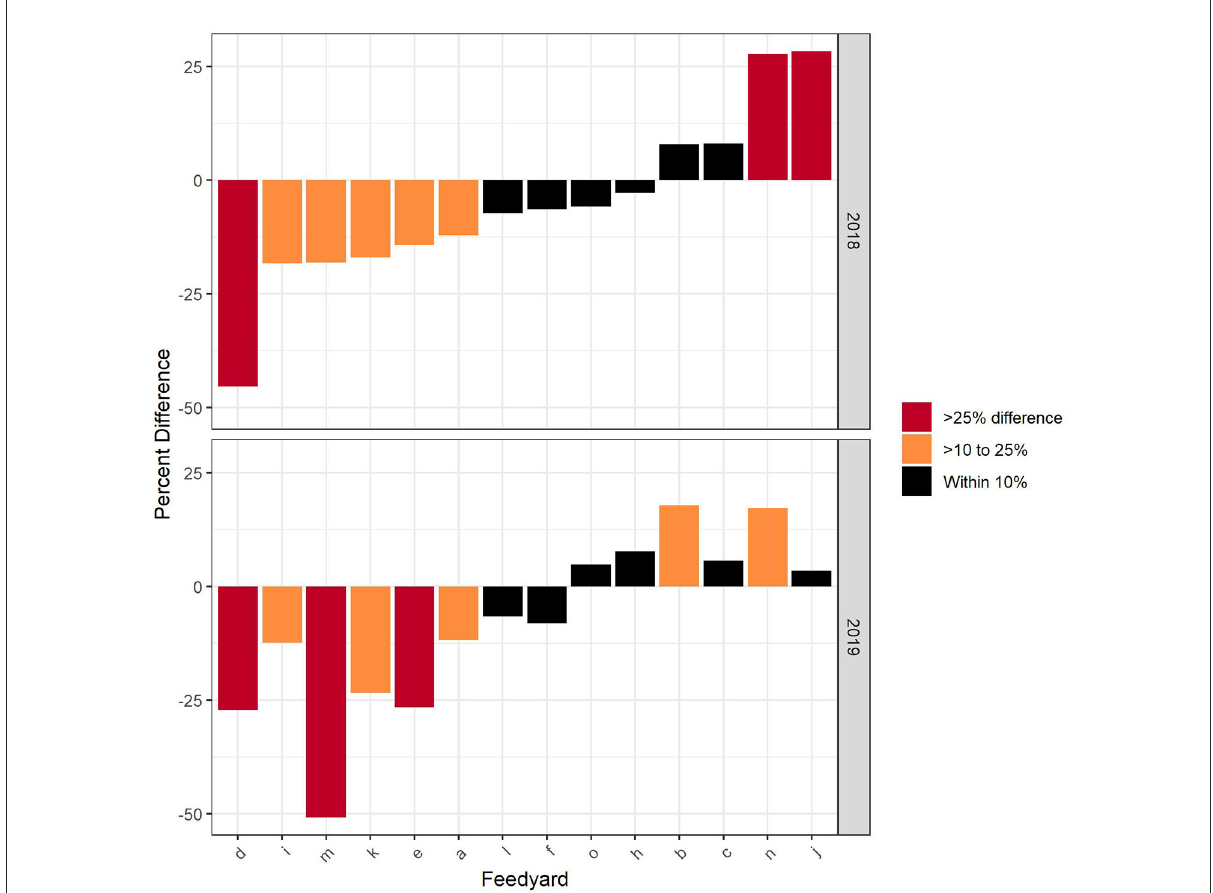
FIGURE3 Comparison of Reg and nDCD at the feedyard level with the difference expressed as the percentage of Reg for each feedyard.